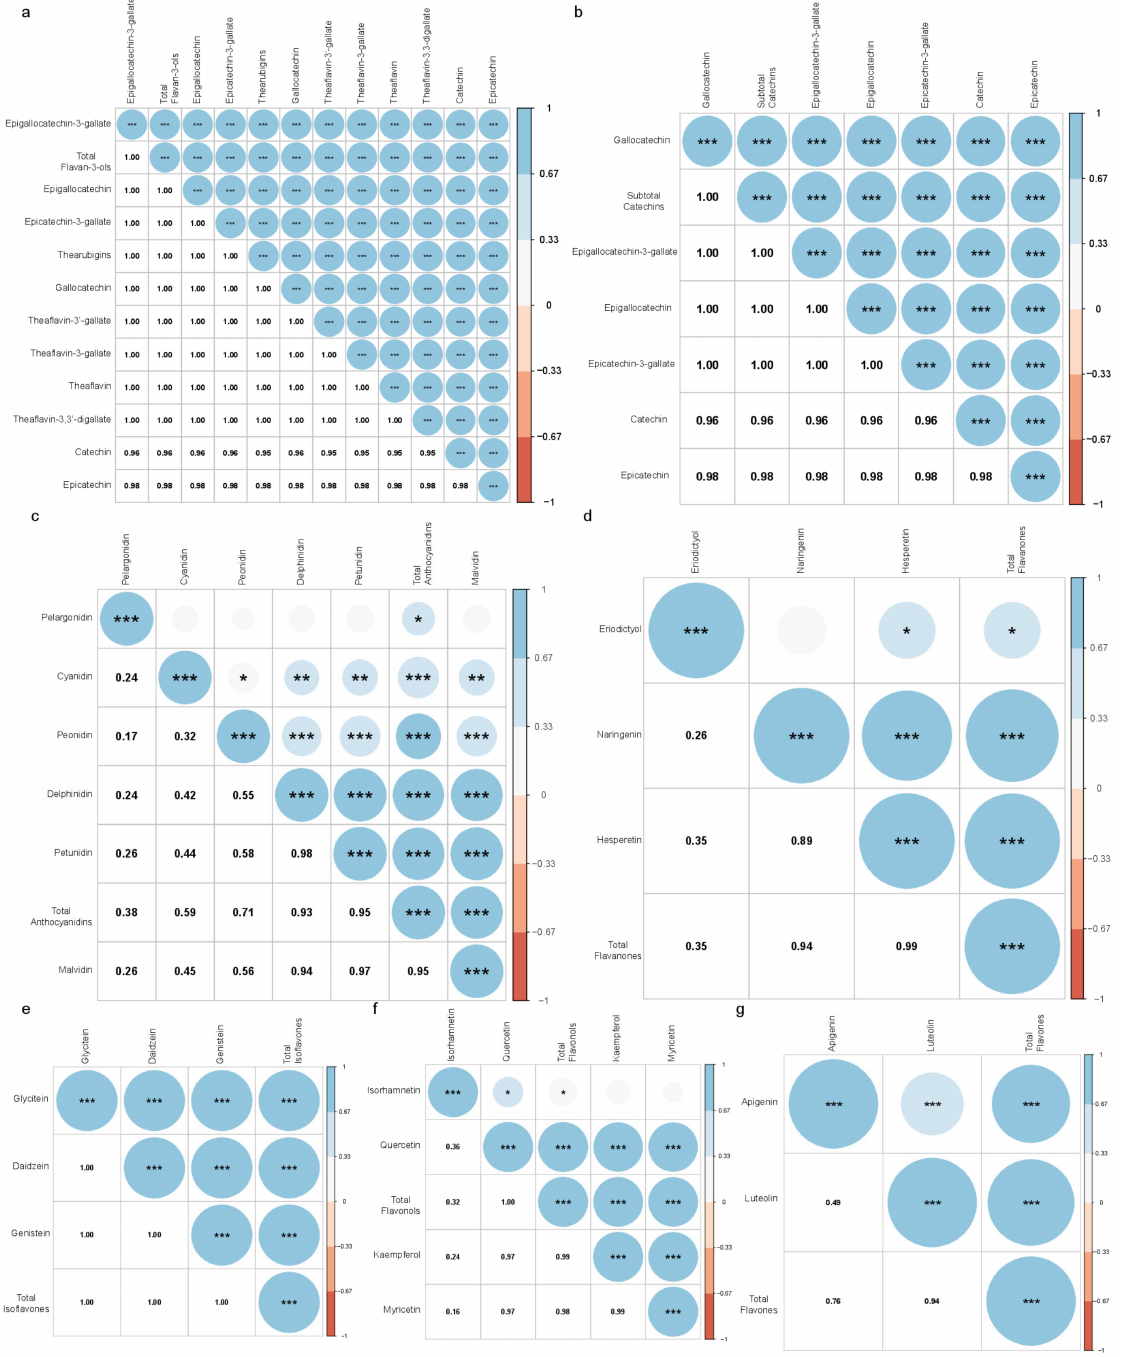
Figure 1. The association between individual flavonoids by the main subclasses. The association between individual flavan-3-ols ( a ), catechins ( b ), anthocyanidins ( c ), flavanones ( d ), isoflavones ( e ), flavonols ( f ), and flavones ( g ) are shown in heatmaps. Correlation was examined by Pearson’s correlation. The Pearson’s correlation coefficients are represented by the color bar. The p values of the correlation are represented by the size of the circle and the asterisks. *** p < 0.001, ** 0.001 (cid:53) p < 0.01, * 0.01 (cid:53) p <